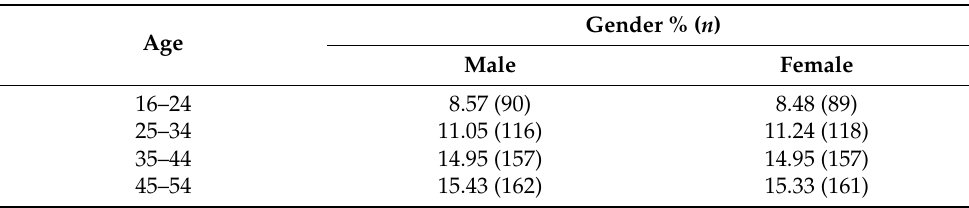
Table 1. Respondents’ characteristics.